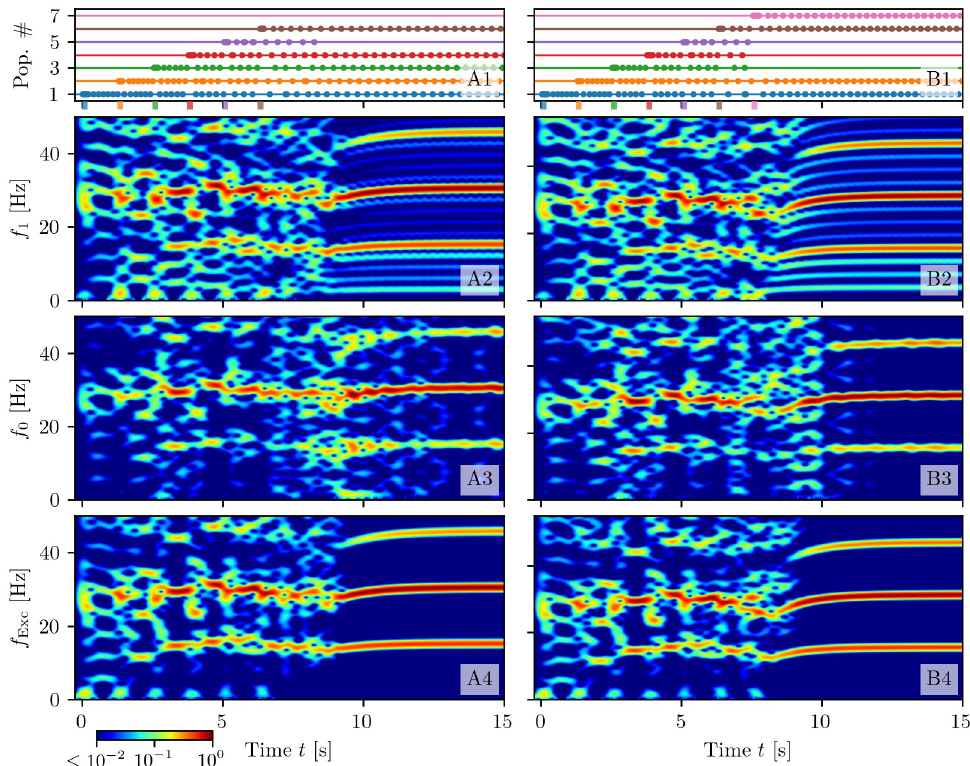
Fig 9. Maximal capacity. Response of the system when N L = 6 (column (A)) or N L = 7 (column (B)) excitatory populations are successively stimulated at a presentation rate of 0.8 Hz. Population bursts of excitatory populations ( A1-B1 ): horizontal lines in absence of dots indicate quiescence phases at low firing rates r k for populations k = 1, ... 7. Dots mark PBs of the corresponding population. The coloured bars on the time axis mark the starting and ending time of stimulating pulses, targeting each population. Spectrograms of the mean membrane potential v 1 ( t ) ( A2-B2 ), v 0 ( t ) ( A3-B3 ) and of the mean membrane potentials averaged over all the excitatory populations ( A4-B4 ); for clarity the corresponding frequencies have been denoted as f 1 , f 0 and f Exc . Parameter values as in Fig